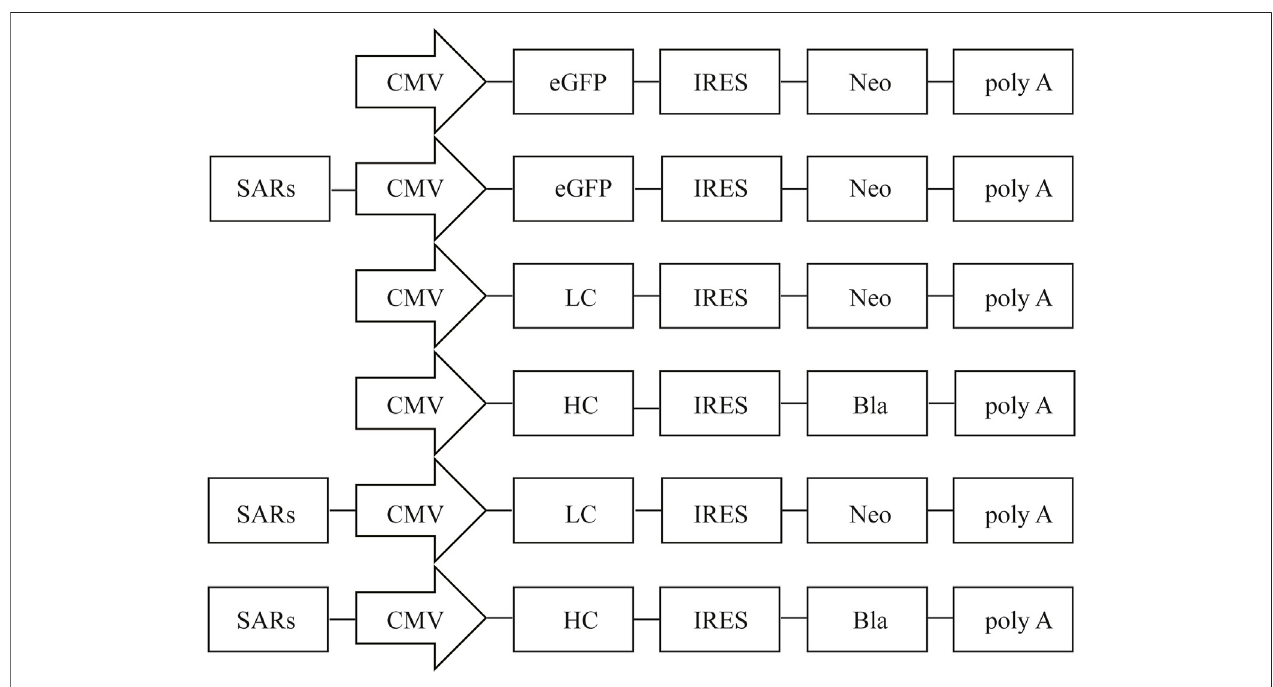
FIGURE 1| Representation of the vectors containing different SARs. Schematic illustration of the expression vector containing different SARs which were inserted upstream of CMV. CMV, human cytomegalovirus IE gene promoter; eGFP, enhanced green fl uorescence protein; IRES, internal ribosome entry site; poly A, polyadenylation signal. Neo, neomycin; Bla, blasticidin.